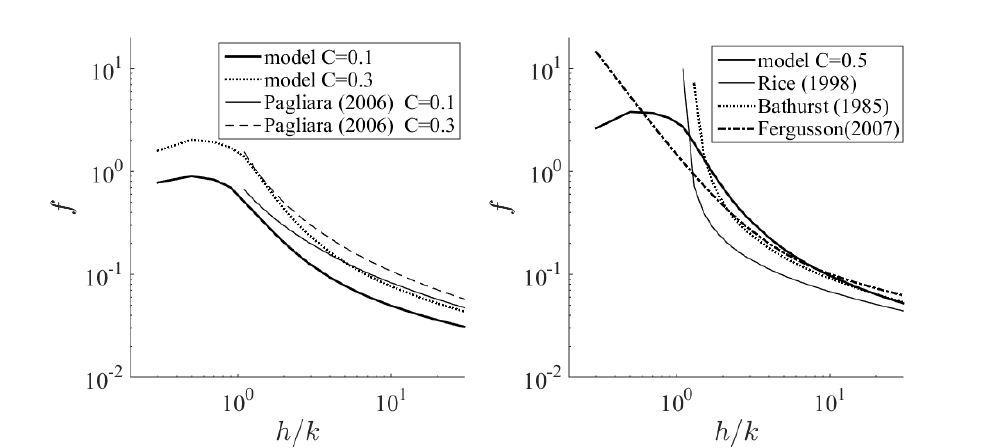
Figure 11. Comparison between the model and experimental correlations for rock ramps and steep slope. For the model k / D = 0.5 and C d 0 = 0.7 deduced from analyzed experiments above